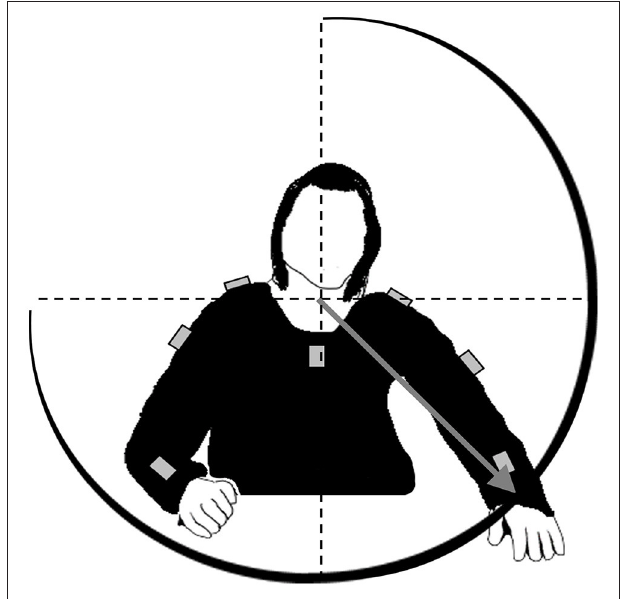
FIGURE 1 | Loci of the sensors (gray boxes) at patients’ upper body. Sensor data are fused to calculate spherical coordinates of the wrist in a reference frame with origin at the upper body, i.e., the intersection between spine and shoulder axis. Four parameters are mapped onto sound: the angle between gray vector and sagittal plane (azimuth angle), the angle between vector and horizontal plane (elevation angle), vector length (radial amplitude), and absolute velocity of the